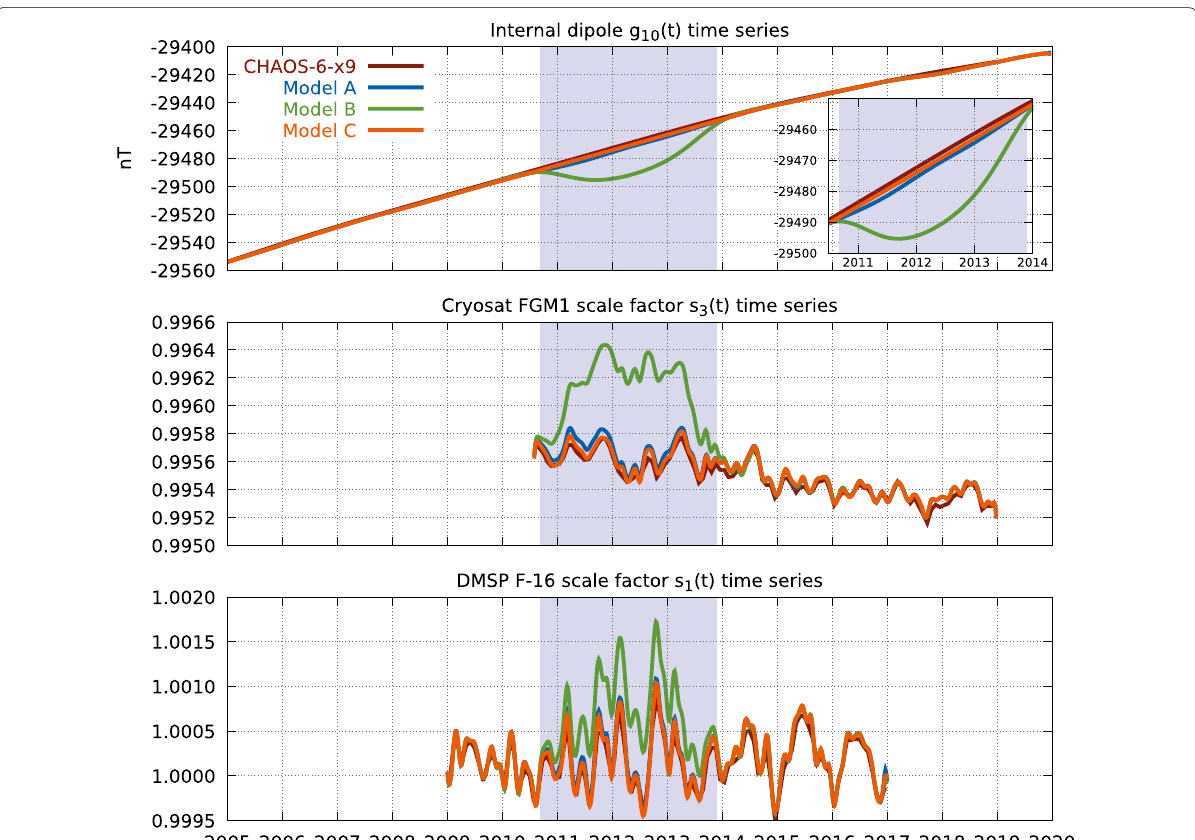
Fig. 5 Top panel: internal dipole g 0 1 ( t ) time series for CHAOS-6-x9 (red), Model A (blue), Model B (green), and Model C (orange). Middle panel: Cryosat FGM1 scale factor s 3 ( t ) derived from CHAOS-6-x9 (red), Model A (blue), Model B (green), and Model C (orange). Bottom panel: DMSP F-16 scale factor s 1 ( t ) derived from CHAOS-6-x9 (red), Model A (blue), Model B (green), and Model C (orange). Blue rectangular region indicates gap period between CHAMP and